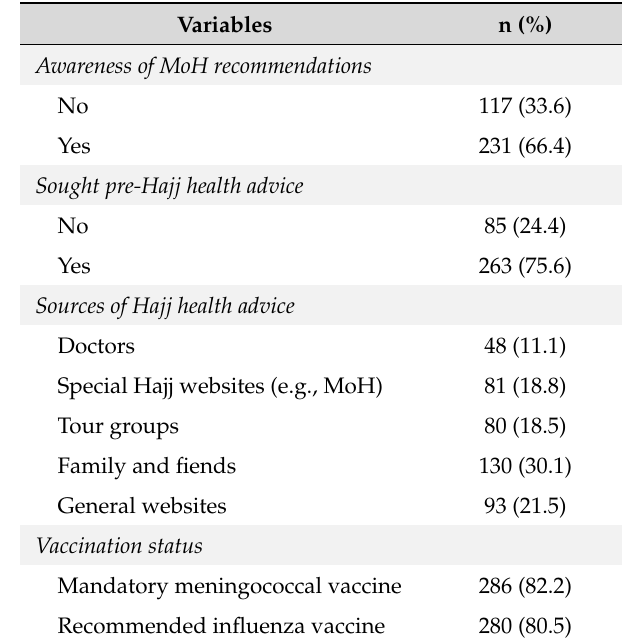
Table 2. Awareness of Saudi Arabian Ministry of Health (MoH) recommendations, pre-Hajj health advice, and vaccination status (N = 348).